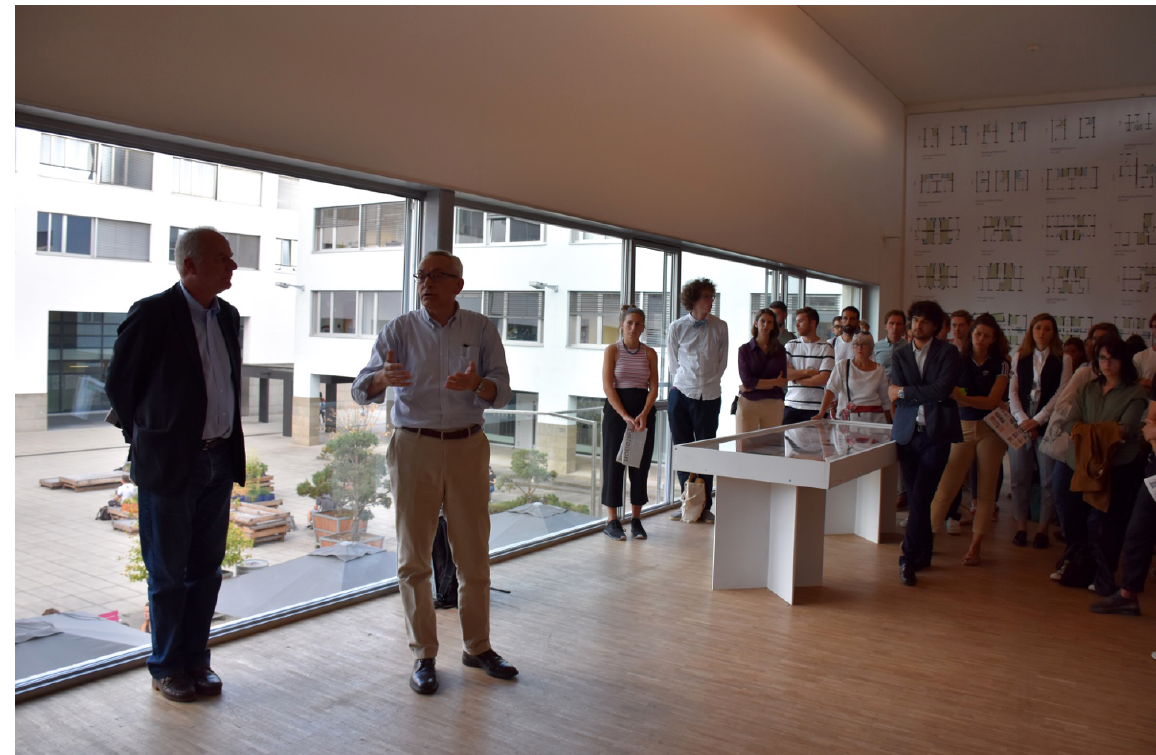
Figure 4. Opening of exhibition introduced by Bruno Marchand and Luca Ortelli’s lectures. Source: Authors.